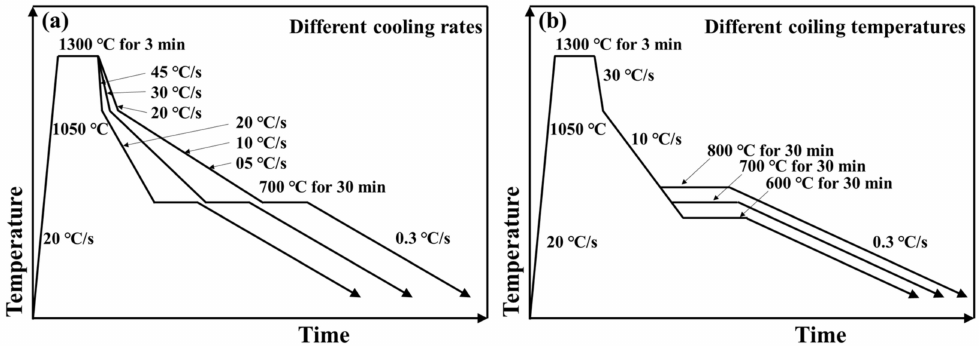
Figure 3. Temperature history in CLSM: ( a ) different cooling rates, ( b ) different coiling